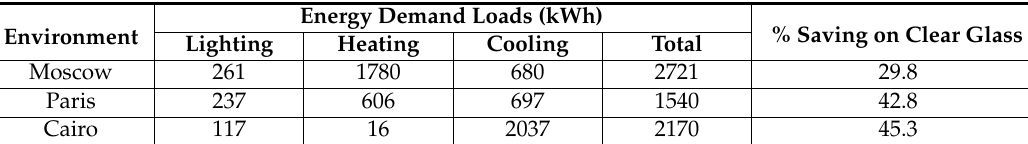
Table 1. Modeling construction materials and properties used for the building